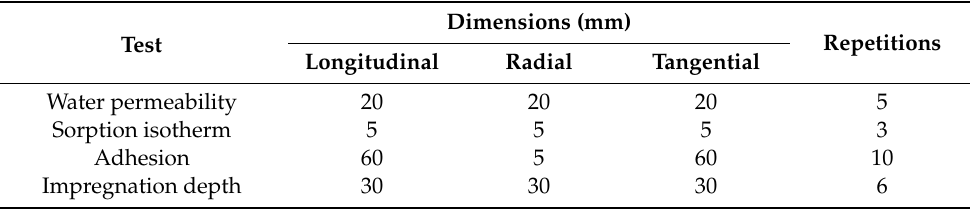
Table 1. Dimensions of the wood samples for the di ff erent tests.